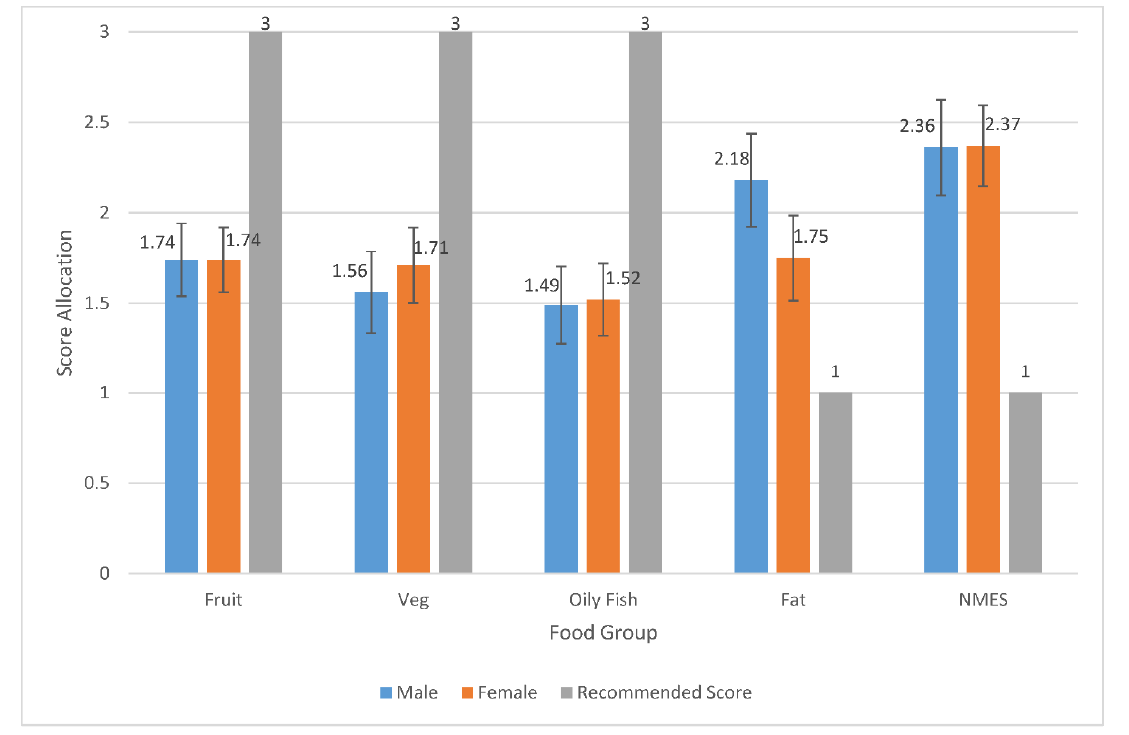
Figure 1. Mean food groups score allocation from the Short Form FFQ, evaluated using DANTE tool per sex compared to the recommended score for each of the food groups.